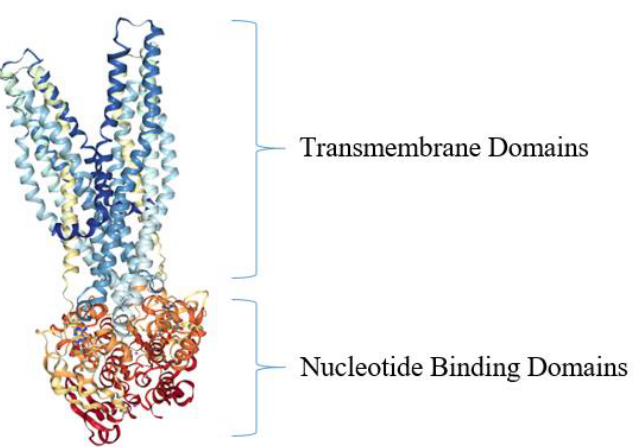
Figure 5. Crystal structure of bacterial ABC efflux pump from S. aureus . The top portion of the ABC transporter Sav1866 is depicted in blue and light blue and represents the two TMDs (sometimes called membrane-spanning domains, MSDs) of the protein, while the orange and red colors depict the two NBDs [104]. The model structure was generated using NGL Viewer [106] of the PDB [107] entries 2HYD and 2ONJ, as reported [104,108].